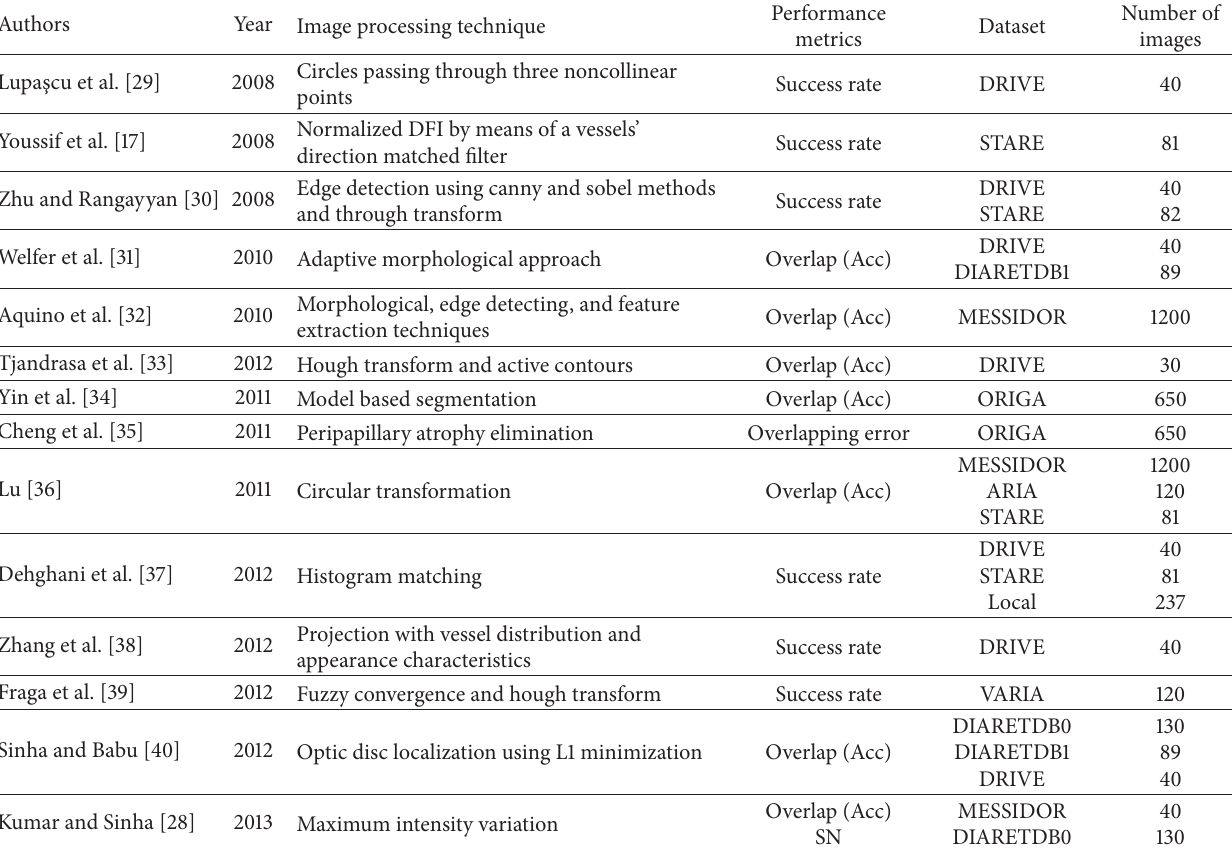
Table 2: Optic disc segmentation